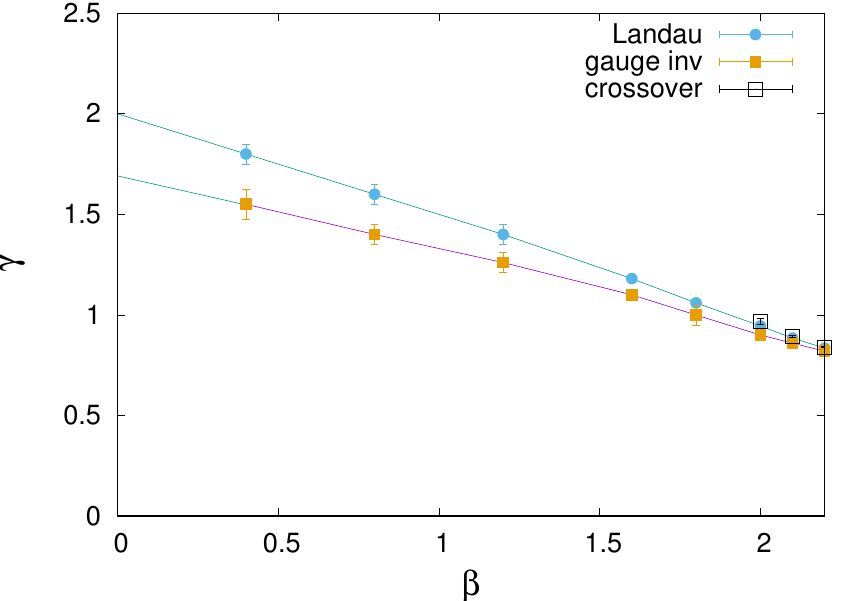
Figure 5. Phase boundaries of global gauge symmetry breaking obtained in Landau gauges and in the gauge-invariant approach in the SU ( 2 ) gauge-Higgs theory, along with the sharp crossover line at β > 2. The figure is taken from Ref.